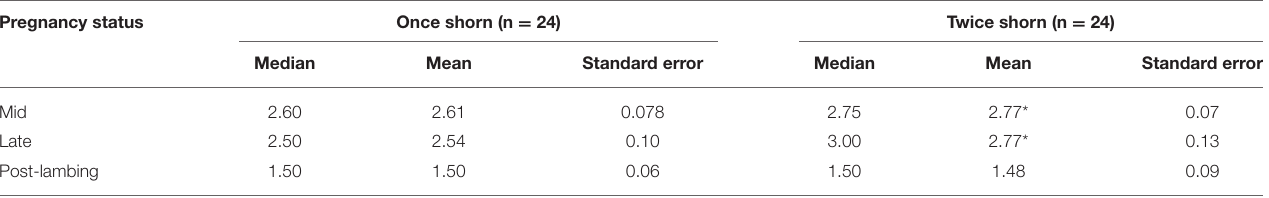
TABLE 1 | Median, mean, and standard error values for ewe condition score across once and twice shorn